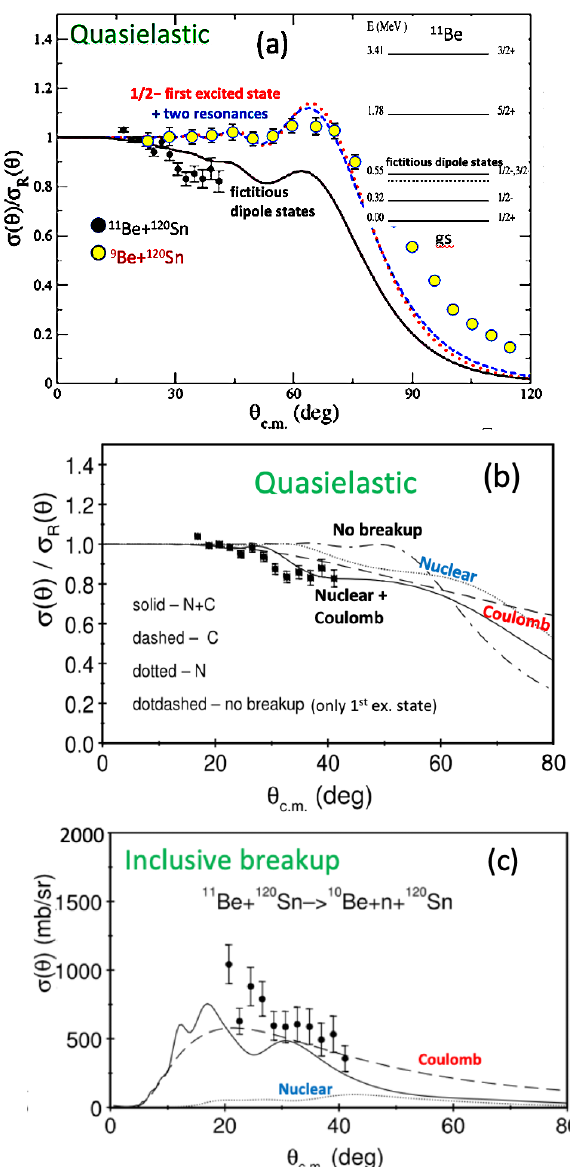
Fig. 7. (a) Angular distribution of the quasielastic cross sections for 11 Be + 120 Sn at E = 32 MeV [30] (black circles), and for the system 9 Be + 120 Sn at similar collision energy. (b) CDCC calculations are compared with the experimental quasielastic cross section (black squares) [31]. (c) Angular distribution of the breakup cross sections. Various calculations are shown with solid, dashed and dotted lines; see text for